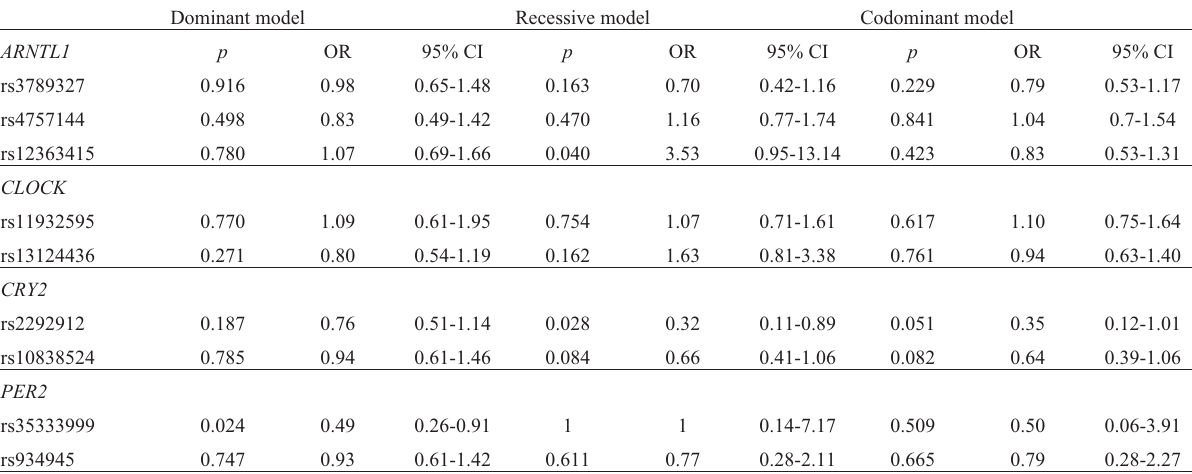
Table 3 - Genotype models of the ARNTL , CLOCK , CRY2 and PER2